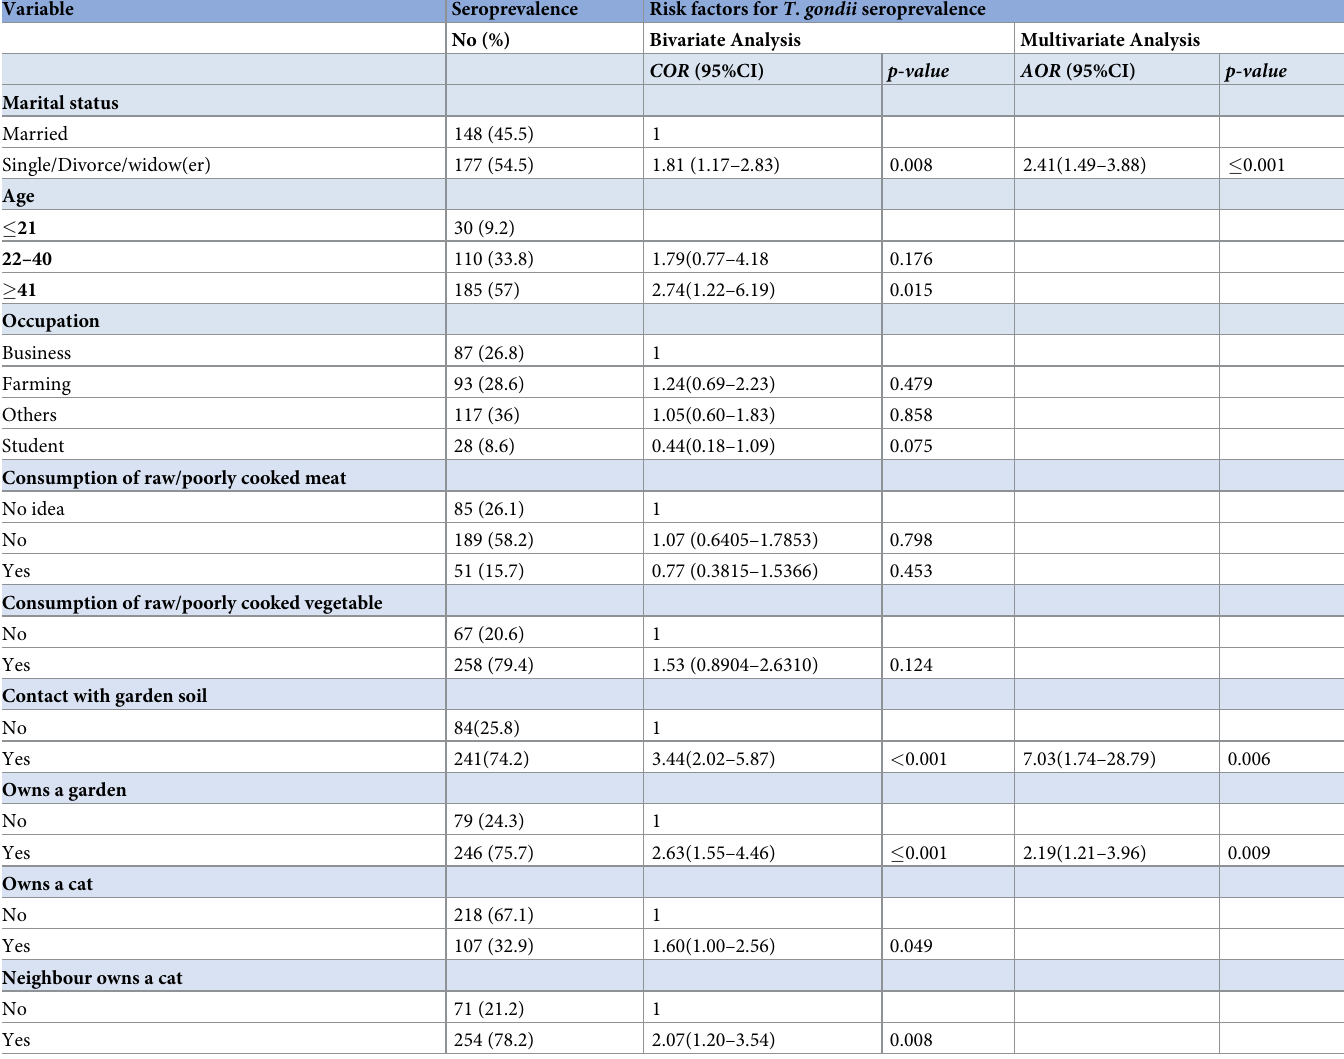
Table 2. Association of T . gondii infection and demographic, nutritional and socio-economic factors among HIV patients in the BHD.